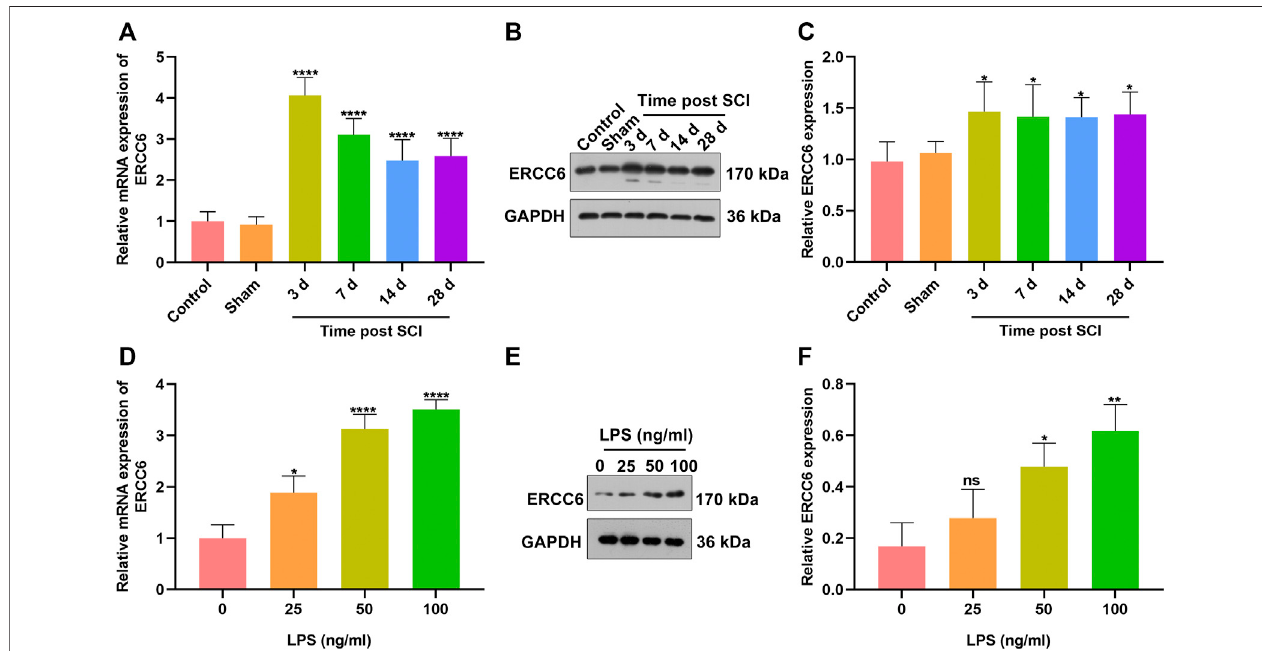
FIGURE 1 | ERCC6 is highly expressed in SCI mice and LPS-induced mouse microglia cells. (A) RT-qPCR analysis of ERCC6 expression in the damaged spinal cord of mouse models on days 3, 7, 14, and 18 following ICI operations as well as control and sham operation mice (N = 8 mice in each group). (B,C) Western blotting analysisofERCC6expressioninthedamagedspinalcordofmousemodelsondays3,7,14,and18followingICIoperationsaswellascontrolandshamoperationmice (N=8miceineachgroup). (D) RT-qPCRanalysisofERCC6expressioninBV2mousemicrogliacellsexposedtodistinctconcentrationsofLPS(N=3miceineach group). (E,F) Western blotting analysis of ERCC6 expression in BV2 mouse microglia cells under exposure to distinct concentrations of LPS (N = 3 mice in each group). p -values were calculated with the ANOVA test. Ns: no signi fi cance; * p -value < 0.05; ** p -value < 0.01; **** p -value <